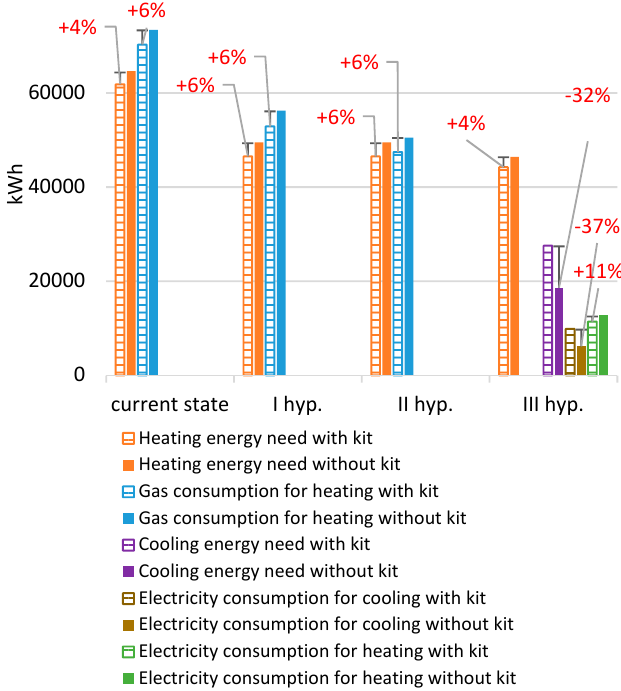
Figure 10. Energy need and consumption, with and without the kit [kWh].